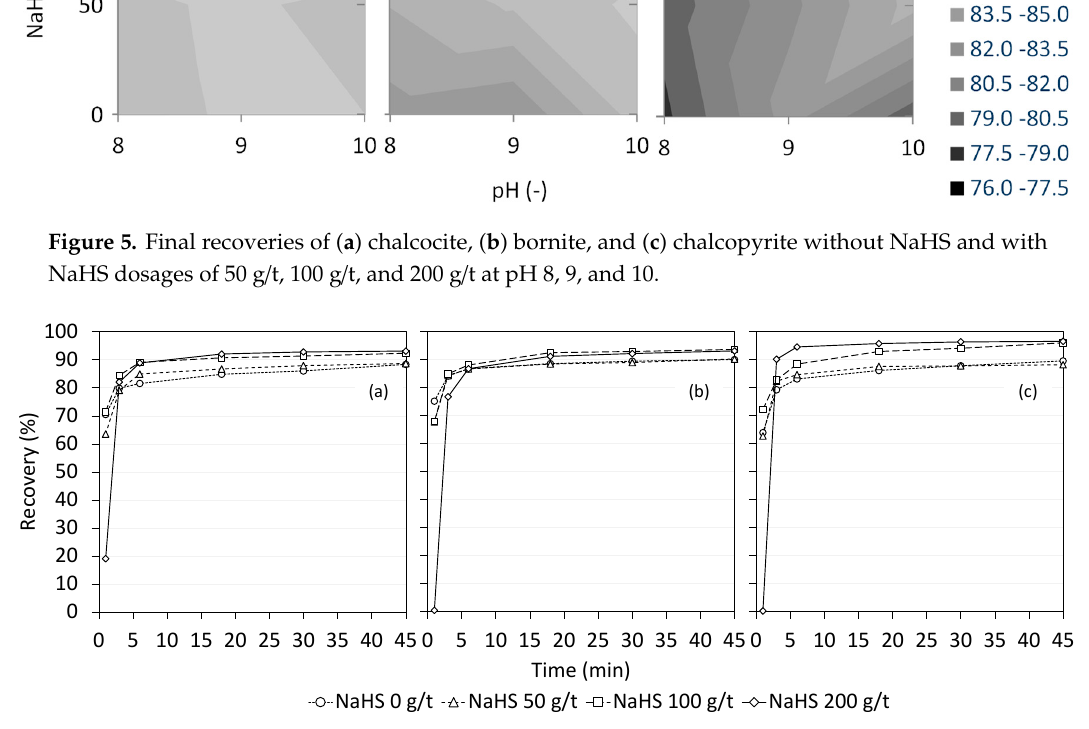
Figure 6. Chalcocite recoveries without NaHS and with NaHS dosages of 50 g/t, 100 g/t, and 200 g/t at ( a ) pH 8, ( b ) pH 9, and ( c ) pH 10.